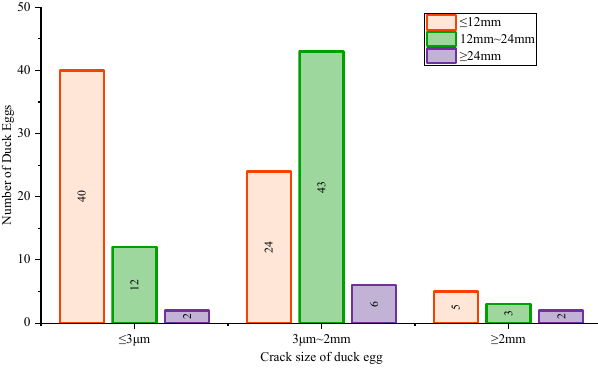
Figure 10. Crack size distribution of cracked duck